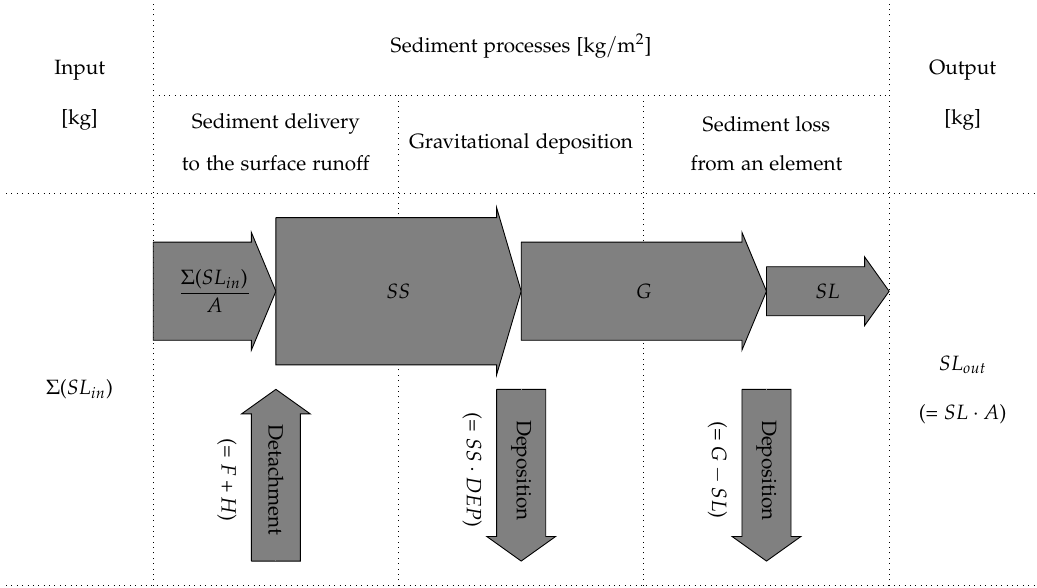
Figure 4. Schematic sediment phase of an element. The model estimates the amount of sediment loss from an element through three steps. In the first step, detached soil particles from an element (by raindrop ( F ) and runoff ( H )) and sediment inputs from upslope elements ( Σ ( SL in ) / A ) are delivered to the surface water of an element. Second, some of the suspended sediments ( SS ) delivered in the runoff settle down due to gravity at the deposition rate of the suspended sediments in the runoff ( DEP ). Third, the model estimates the amount of sediment loss from an element by comparing the transport capacity of the runoff ( TC ) and sediments available for transport ( G ), which are the remaining suspended sediments after gravitational deposition process. If TC is larger than G , all the remaining sediments in the water (i.e., G ) are washed away from an element. Otherwise, the amount of sediments equal to TC is carried out by the surface runoff to downslope